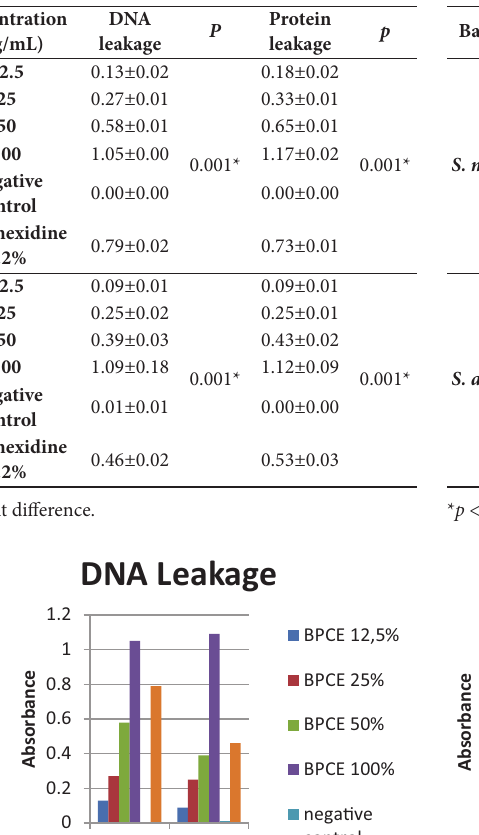
Table 3. Calcium and potassium ions leakage of Medan BPCE against S . mutans and S. aureus .